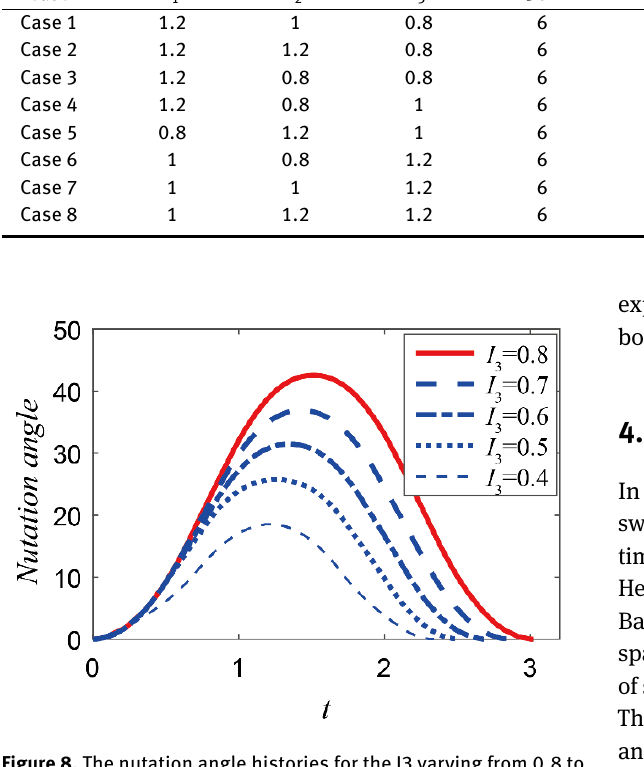
Table 2. The total numbers of switches for various cases Case